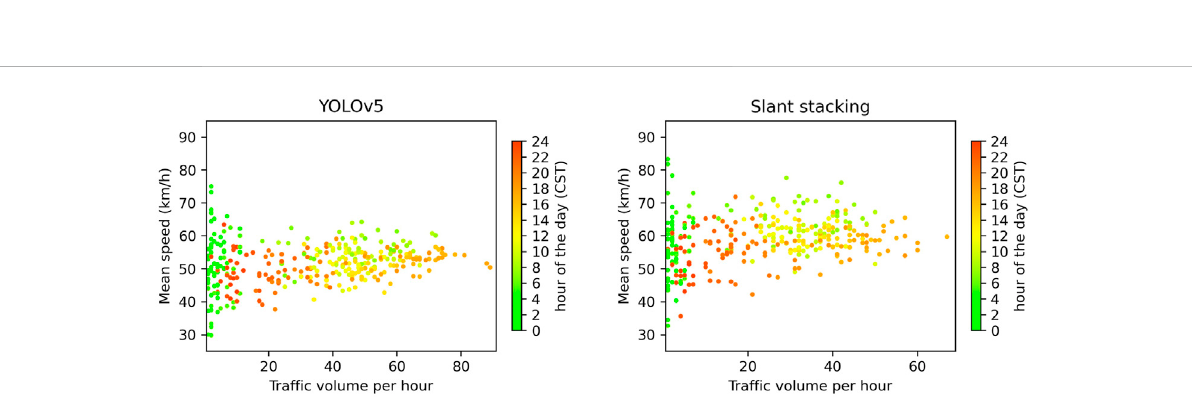
FIGURE 9 Relationship between the traf fi c volume and mean speed derived from the detection results of YOLOv5 (left) and slant stacking (right). The colors of the scatters represent the time of the